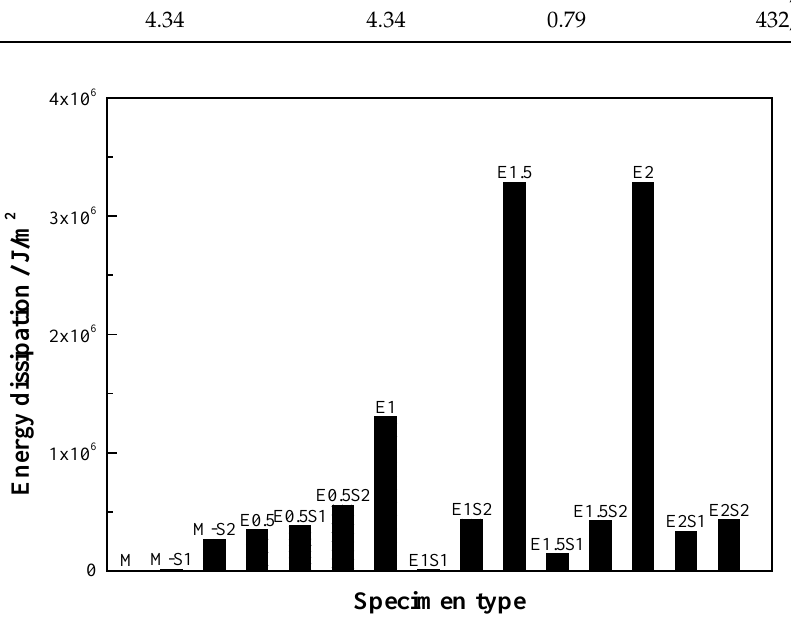
Figure 11. Comparison of energy dissipation of different types of steel grid-PE fiber reinforced ECC specimens.